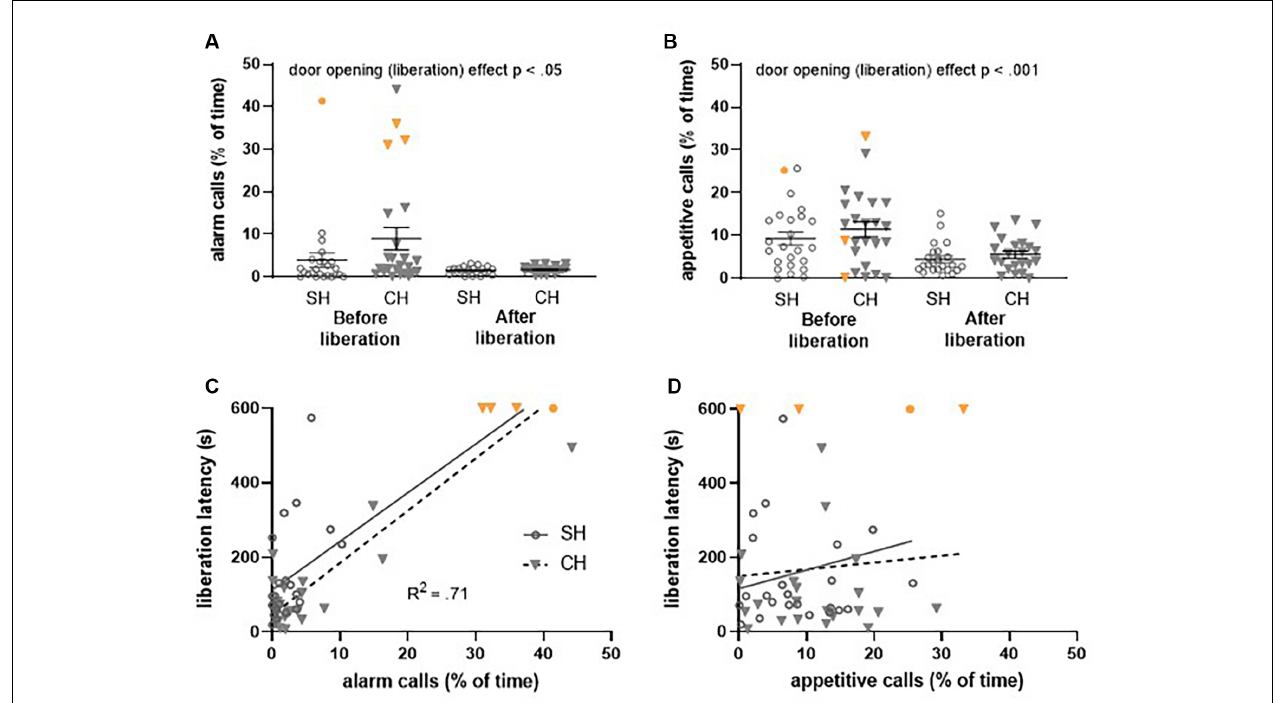
FIGURE 6 | Ultrasonic vocalizations (USVs) recorded during the first (FR1) trial of the Escape to Box 1 configuration, in the complex housing experiment. Vocalizations are presented as the percentage of time rats emit these USVs. Per experimental group, 24 pairs of rats were included of which four rats (three complex housed and one standard housed rat) did not liberate their cage mates (data points depicted in orange). For a proper comparison of USVs before and after door opening, these data points were not included in the statistical analysis. (A) 22 kHz (alarm) calls and (B) 50 kHz (appetitive) calls before and after liberation for standard and complex housed rats. (C) The relation between 22 kHz vocalizations (before liberation) and liberation latency and (D) the relation between 50 kHz vocalizations (before liberation) and liberation latency. SH, standard housed (black line); CH, complex housed (dashed line). Data represent individual data points and mean ±